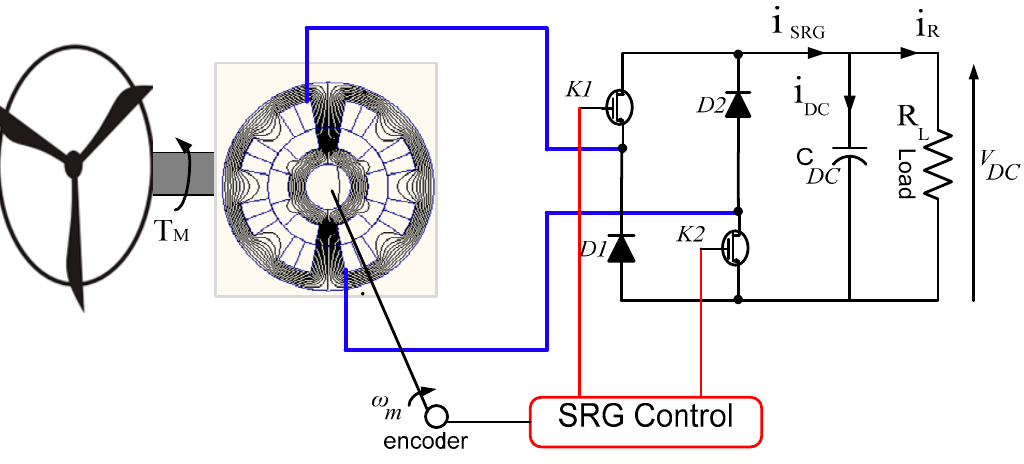
Figure 2. Principle of SRG operation.